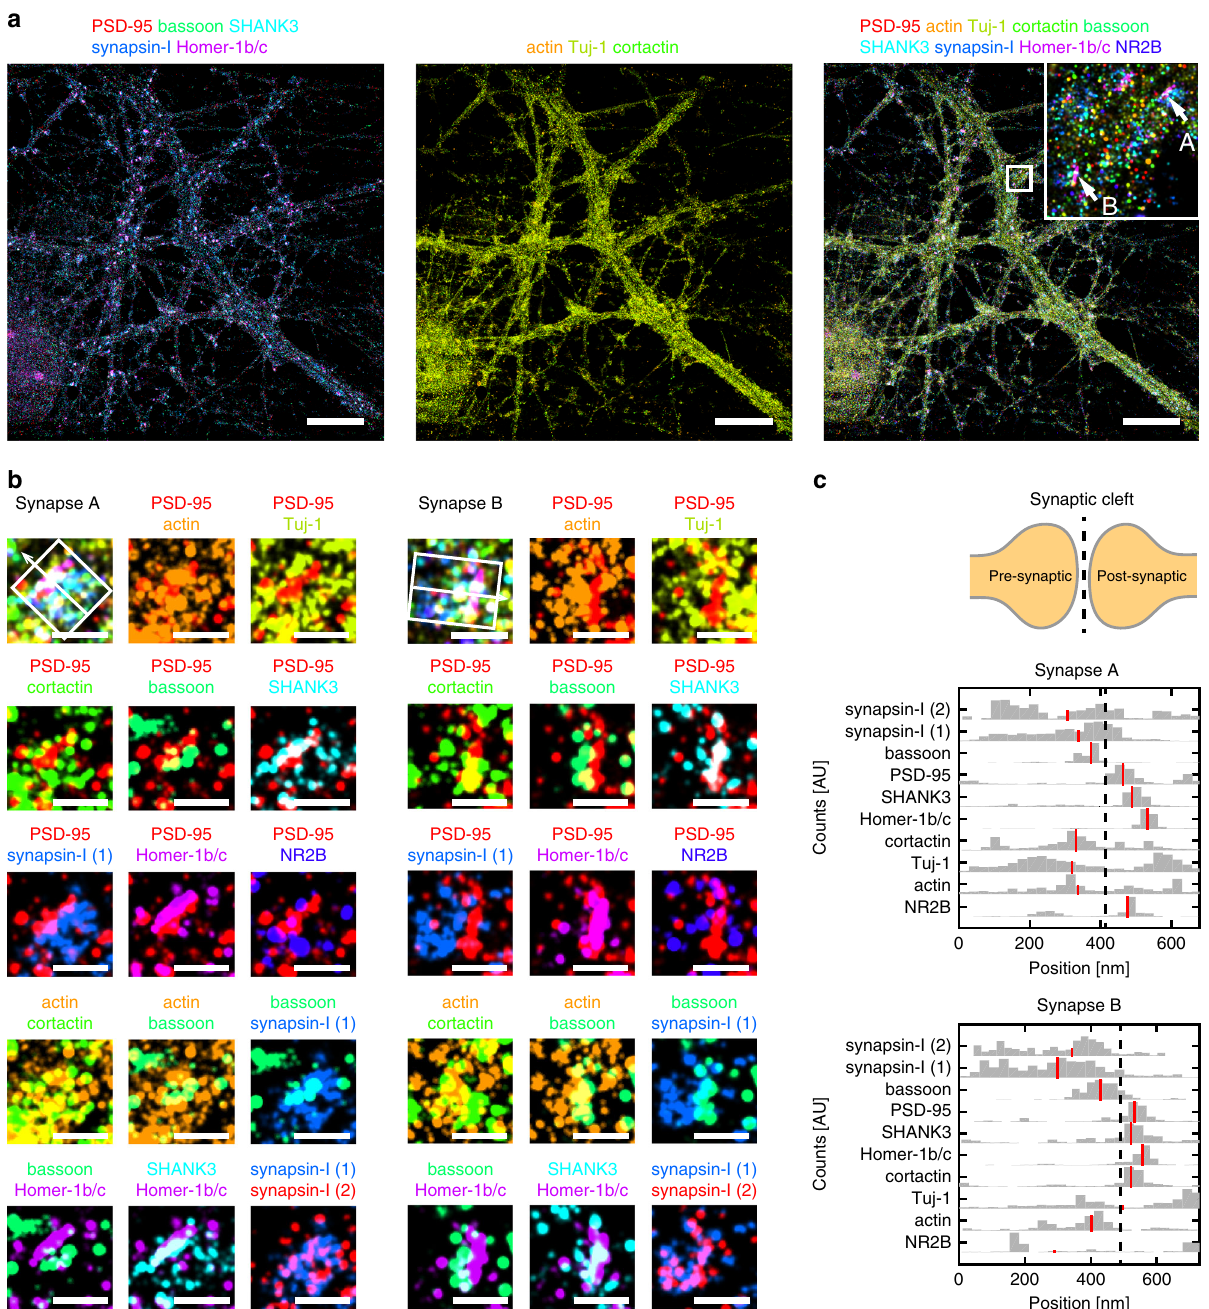
Fig. 7 Distributions of synaptic proteins within individual synapses. a DNA-PRISM images of neurons showing the subset channels of synaptic proteins (left), the subset channels of cytoskeletal proteins (middle), and all the channels (right). b Zoom-in view of two individual synapses in a shows the separation of pre-synaptic proteins (synapsin-I and bassoon) and post-synaptic proteins (PSD-95, SHANK3, Homer-1b/c). For each synapse, the nine- target image is shown in the top-left corner, with distinct pairs of synaptic proteins shown in the remaining images. Synapsin-I was imaged twice, once at the beginning and once at the end of the experiment. c Cross-sectional pro fi les of protein distributions along trans-synaptic axes (white boxes with arrows in b ) of the two synapses in b . Red lines indicate the medians of the distributions. Scale bars: 10 μ m in full fi eld views; 500 nm in zoom-in